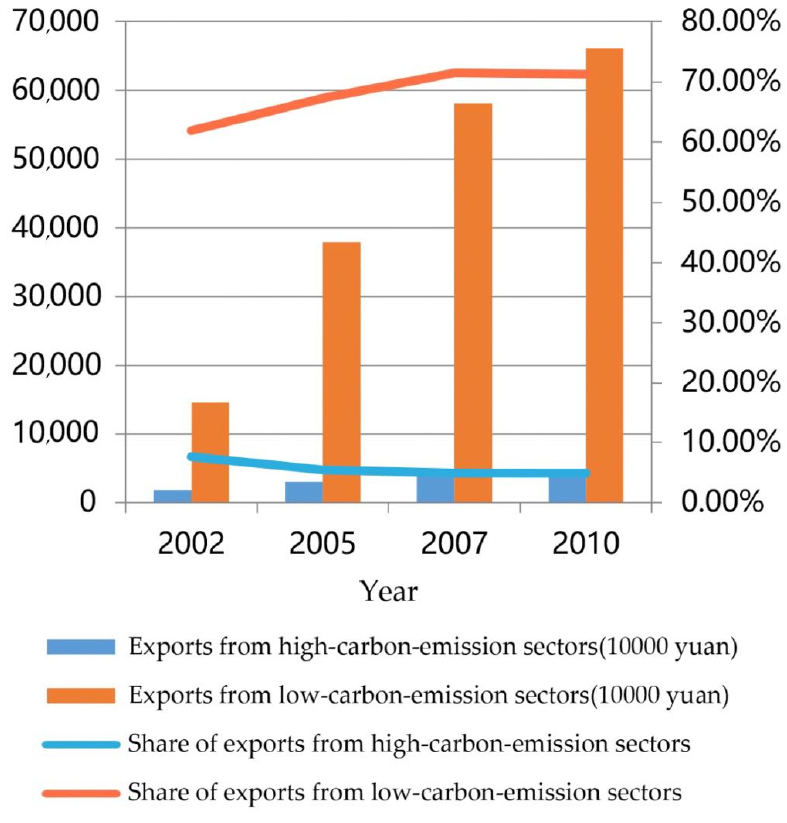
Figure 6. Export volume and export volume share of high-carbon-emission sectors and low-carbon- emission sectors.